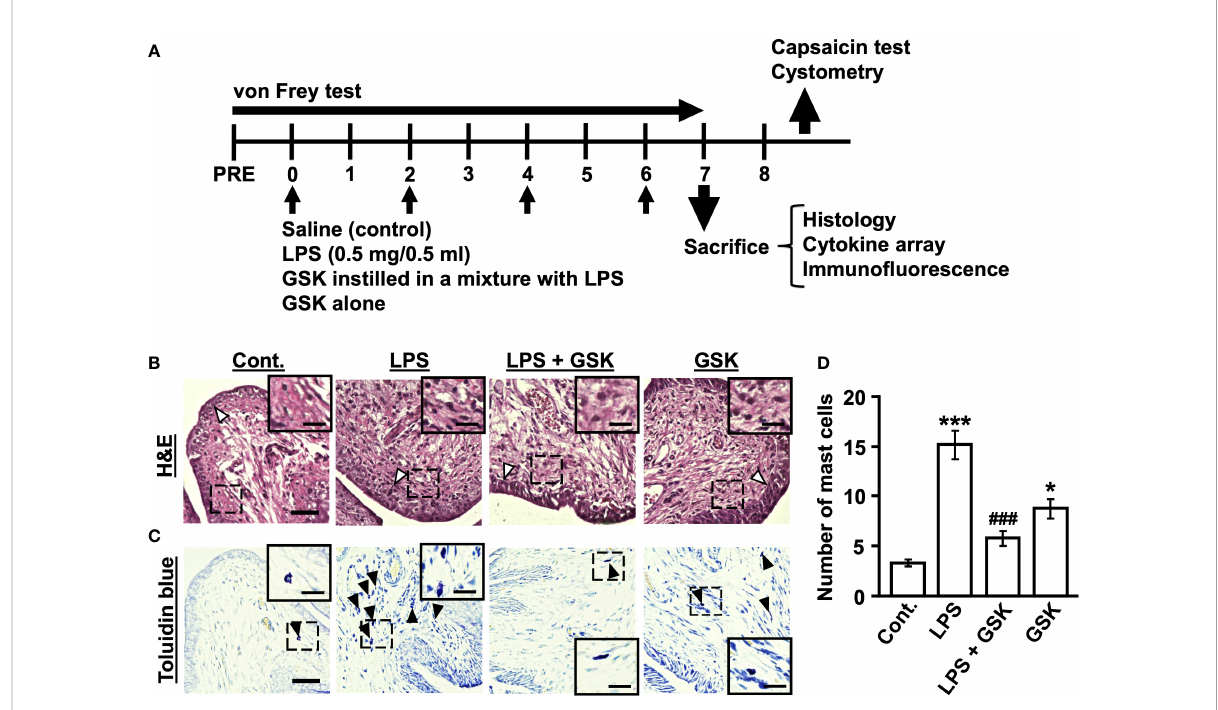
FIGURE 1 GSK reduced LPS-induced in fl ammatory reaction and the number of mast cells in rat bladder. (A) Schematic diagram of the experiments in chronic cystitis rats. The bladders of rats were instilled with LPS (0.5 mg/0.5 ml in vehicle) or the selective TRPV4 agonist GSK1016790A (GSK) in a mixture with LPS once every 48 h for 4 days. (B) Photomicrographs of hematoxylin and eosin (H&E) staining in rat bladder samples. The thickness of bladder epithelial cell indicated by white arrows. (C) Representative photomicrographs of rat bladder samples stained with toluidine blue (black arrows) showing mast cells. Magni fi cation 40× (object lens), scale bars, 50 m m. The boxed region from the merge is enlarged in the inset (scale bars, 20 m m). (D) Plot showing the number of mast cells in the bladder of rats. Data represent the mean ± SEM; n = 4 for each group. * P < 0.05, *** P < 0.001 vs control. ### P < 0.001 vs